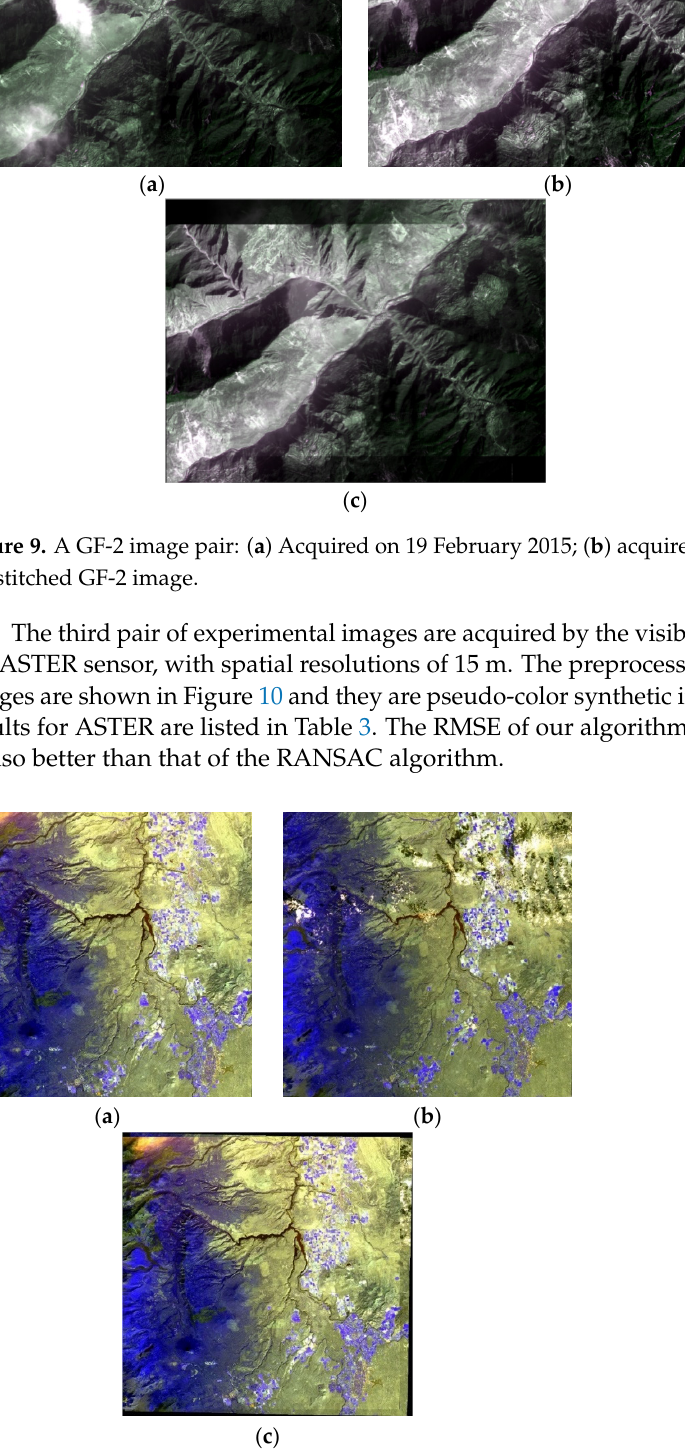
Figure 10. An ASTER (Advanced Spaceborne Thermal Emission and Reflection Radiometer) image pair: ( a ) Acquired on 15 August 2020; ( b ) acquired on 20 October 2020; ( c ) the stitched ASTER